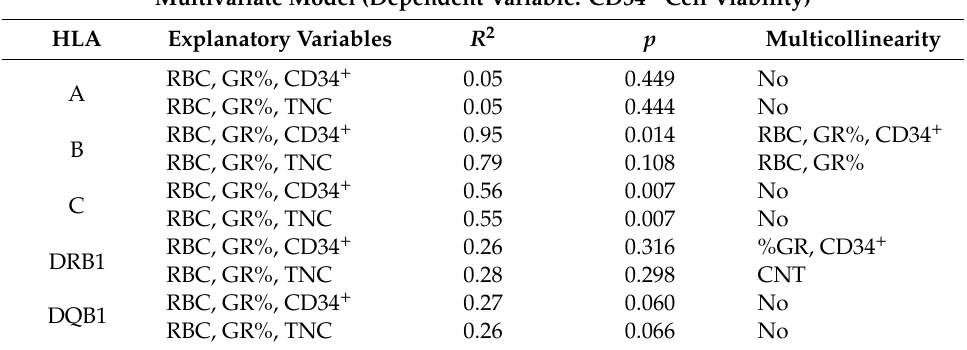
Table 2. General multivariate linear regression model with CD34 + viability after thawing as the dependent variable and HLA genotypes, pre-cryopreservation RBC, GR%, and viable CD34 + cell count as explanatory variables. There was only statistical significance in the model with HLA-B and HLA-C genotypes. All continuous variables exhibited multicollinearity in the HLA-B model according to the variance inflation factors